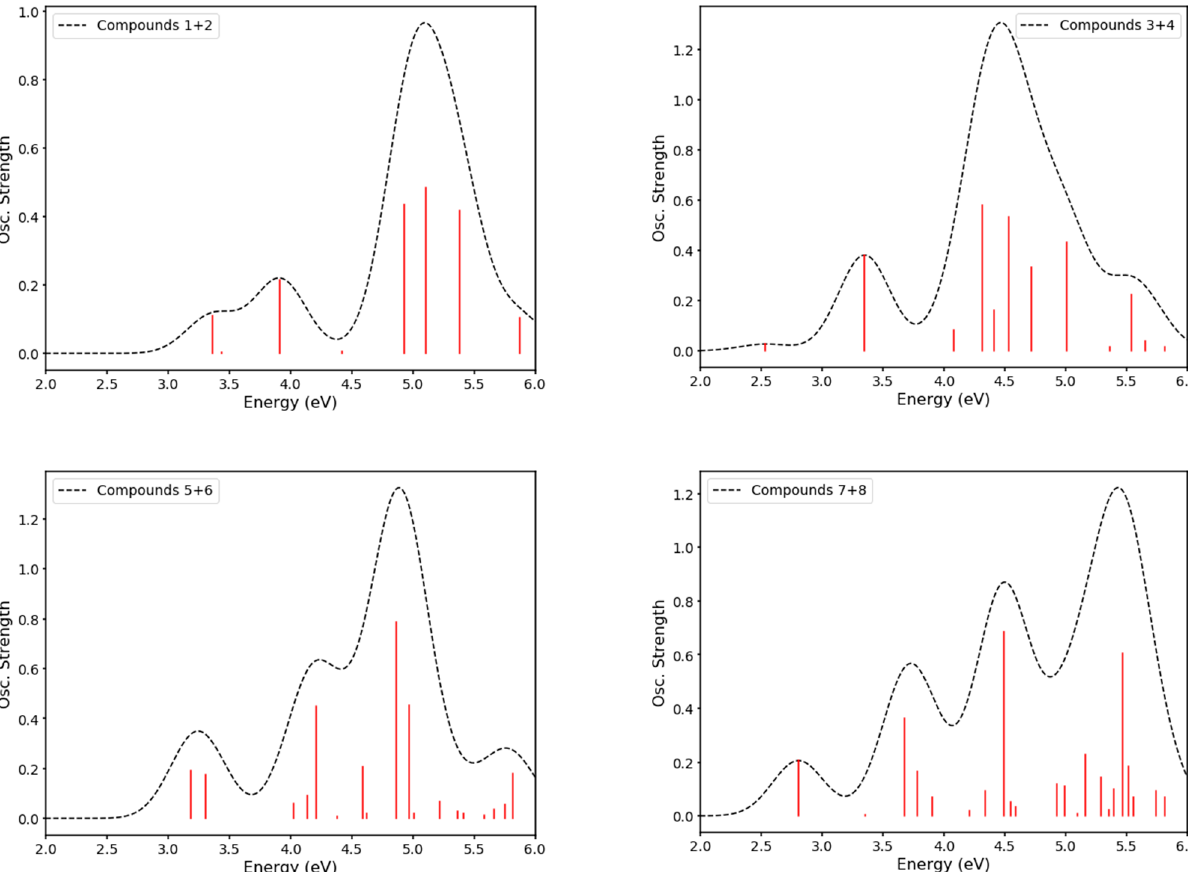
Figure 4. Vertical transitions calculated with TD-DFT and oscillator strength. Flavins denoted as 1+2 (phenyl moiety), 3+4 (naphthalene moiety), 5+6 (phenanthrene moiety), and 7+8 (pyrene moiety).